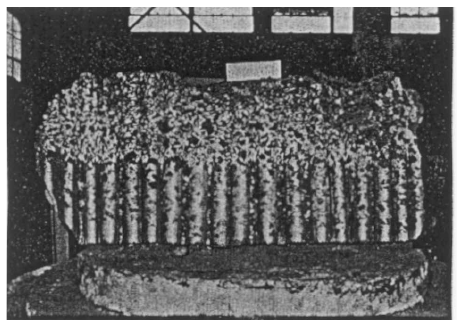
Figure 2. Cross-section of the frozen hearth. Reproduced with permission from [4], Springer, 1987.